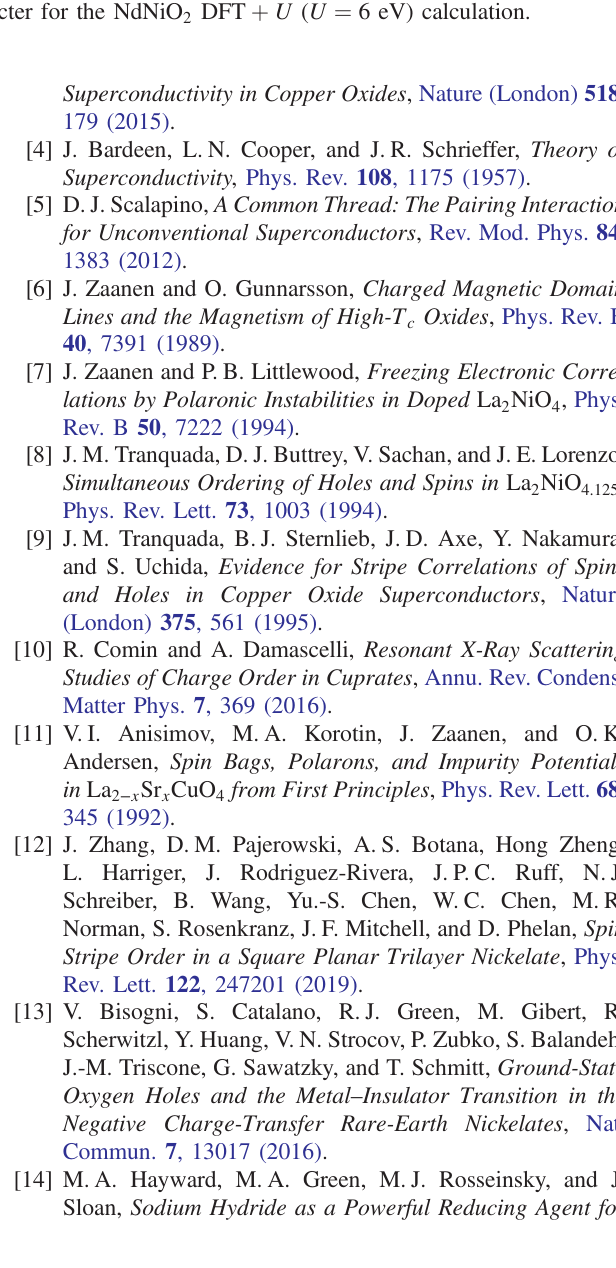
FIG. 10. Highlighted Ni 3 d x 2 − y 2 and 3 d z 2 orbital character for the NdNiO 2 DFT þ U ( U ¼ 6 eV)